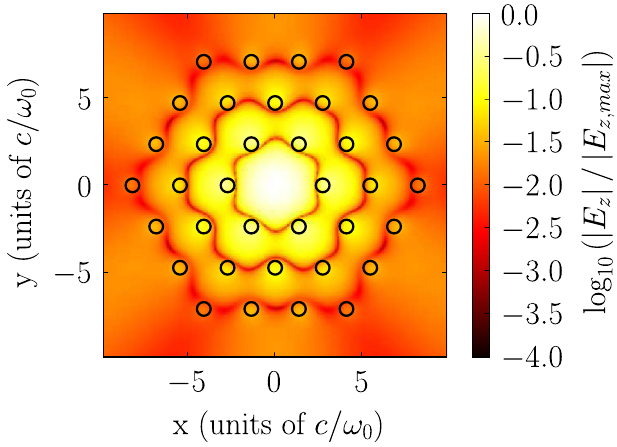
FIG. 2. (Color) Axial electric field strength for a PhC cavity in a triangular lattice of dielectric rods. ! 0 is the resonant frequency and c is the speed of light. The 36 black rings indicate the positions and diameters of the dielectric rods.